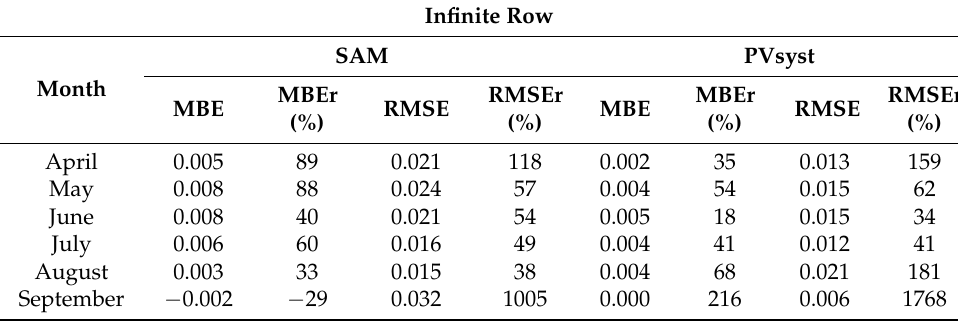
Table 4. Deviation parameters between the Matlab tool, SAM, and PVsyst for situation